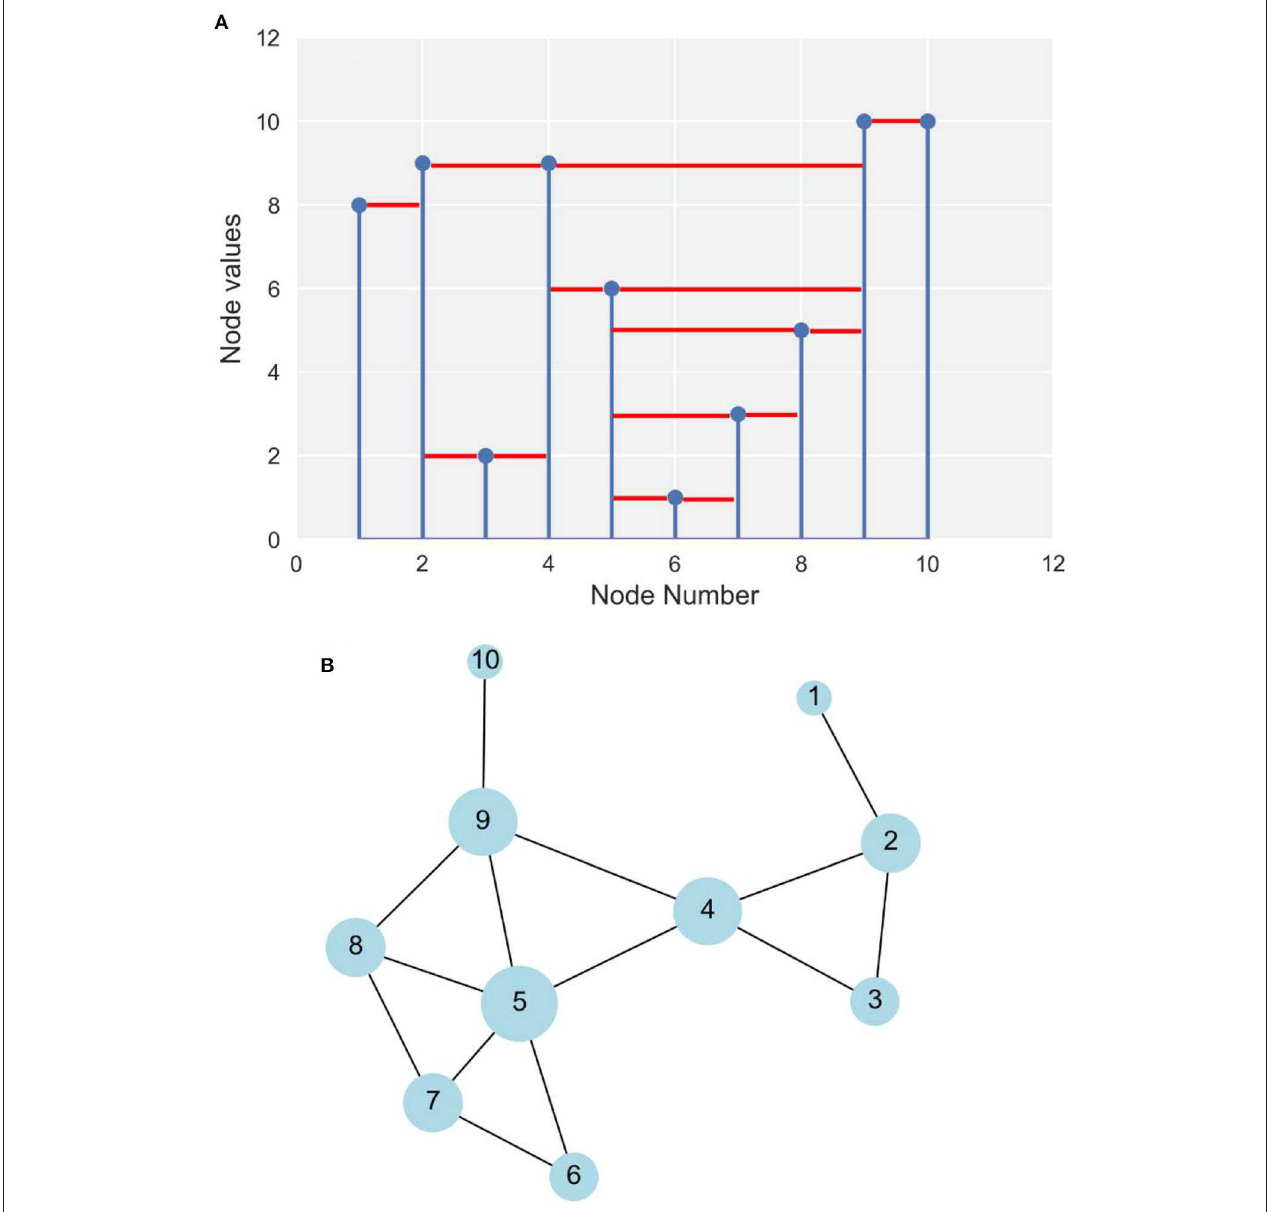
FIGURE 1 | Schematic illustration of horizontal visibility graph (HVG) approach. (A) Indices of nodes with corresponding values. The solid red lines show whether corresponding nodes are horizontally visible to each other. For example, in node 4 we can draw a horizontal straight line between node 4 and node 2 that does not intersect the height of node 3. Thus, node 4 is connected to node 2. Similarly, node 4 is connected to nodes 3, 5, and 9, but not, for example, node 6, since there is no way we can draw a horizontal line without crossing the height of node 5. (B) The complete network.